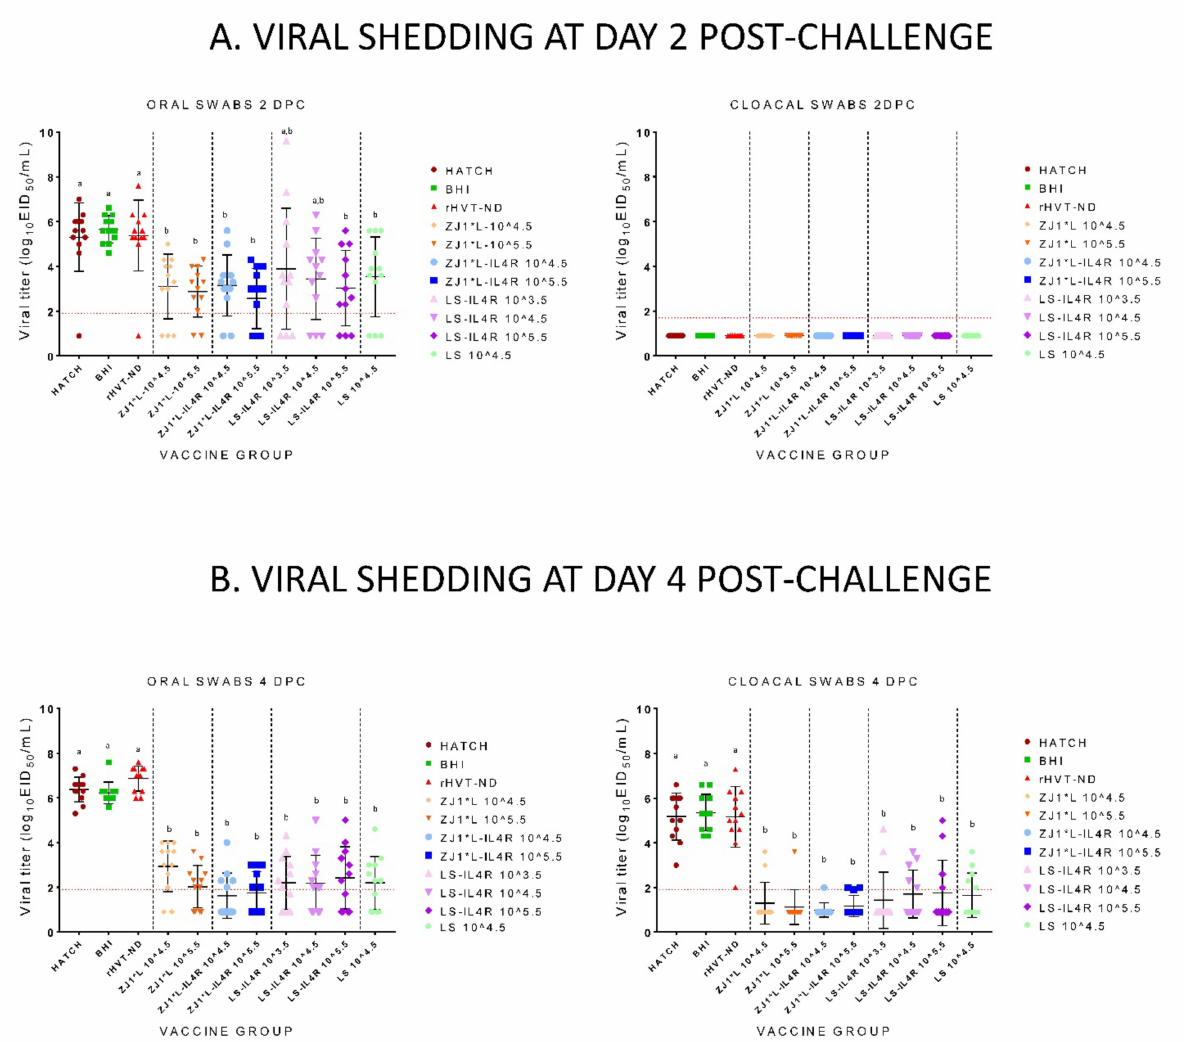
Figure 5. Mean post-challenge viral shedding from chickens after inoculation of commercial eggs at 18 days of embryonation with experimental in ovo vaccines and early challenge with virulent Newcastle disease virus at 14 days post-hatch. Each data point represents NDV titers detected in oropharyngeal (OP) and cloacal (CL) swabs at different days post-challenge (DPC). Shedding is presented separately for 2 days post-challenge ( A ) and 4 days post-challenge ( B ). Bars represent standard deviations of the mean. All swabs from which virus was not detected were given a numeric value of 1 log below the limit of detection. The limit of detection of rRT-PCR is presented as a horizontal dotted line. Statistically significant differences between the different groups are presented with lowercase letters above each group ( p value < 0.05). Group abbreviations: HATCH—eggs not inoculated; BHI—eggs inoculated with BHI; rHVT-ND—eggs inoculated with recombinant HVT vaccine; ZJ1*L—eggs inoculated with the recombinant ZJ1*L virus whose cleavage site was modified to be of low virulence; ZJ1*L-IL4R—eggs inoculated with the recombinant low virulent ZJ1*L with the interleukin-4 gene inserted in reverse orientation; LS—eggs inoculated with the LaSota strain; LS-IL4R—eggs inoculated with the recombinant LaSota virus with the interleukin-4 gene inserted in reverse orientation. The virus dose that the eggs in each group received is represented as a number after the group name in EID 50 /per